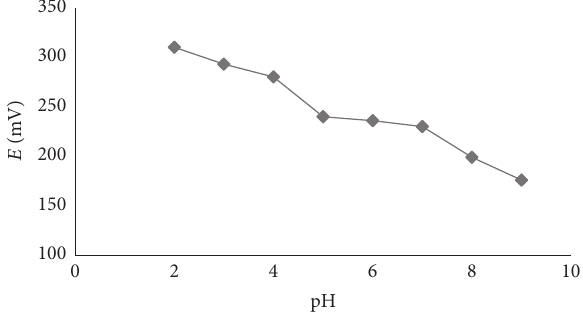
F 3: SEM micrograph of dipyridile amine MWCNT.